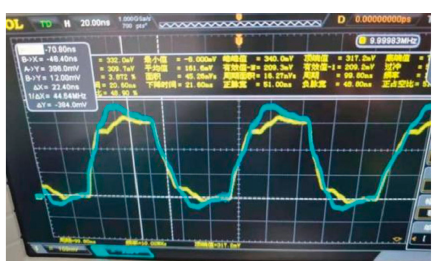
Figure 8: The clock signal of two synchronous